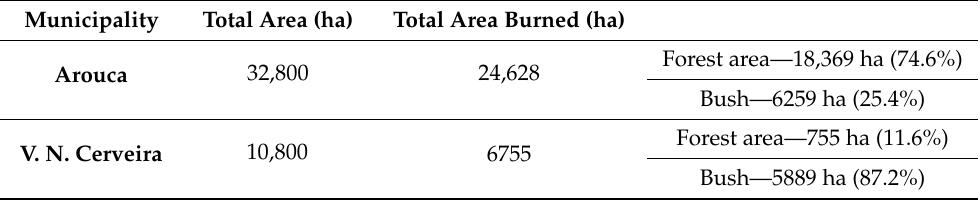
Table 6. Total area burned in Arouca and V.N. Cerveira municipalities in the 2016 fires [41].